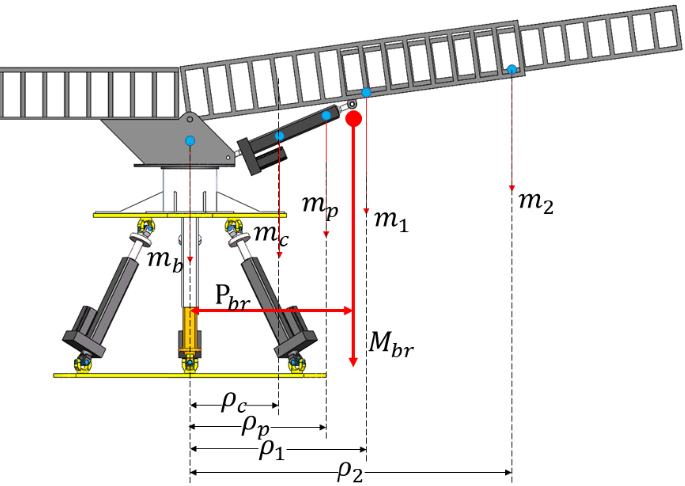
Figure 7. The barycenter of the transfer gangway and its horizontal location. Where m b , m c , m p , m 1 , m 2 indicate the masses of the slewing mechanism, the cylinder of the pitching motor, the rod of the pitching motor, the main arm and the telescopic arm, respectively, ρ c , ρ p , ρ 1 and ρ 2 indicate the distances of the barycenter of the cylinder of the pitching motor, the rod of the pitching motor, the main arm and the telescopic arm from the pitch axis, respectively. The mass of the equivalent barycenter of the transfer gangway is represented by M br , and the distance of the equivalent barycenter from the pitch axis is represented by P br